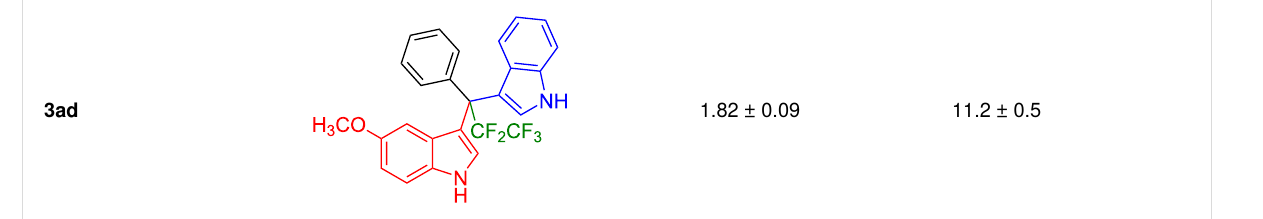
Table 5: Binding affinities of unsymmetrical fluoromethyl-substituted DIM derivatives for cannabinoid receptors. (continued)